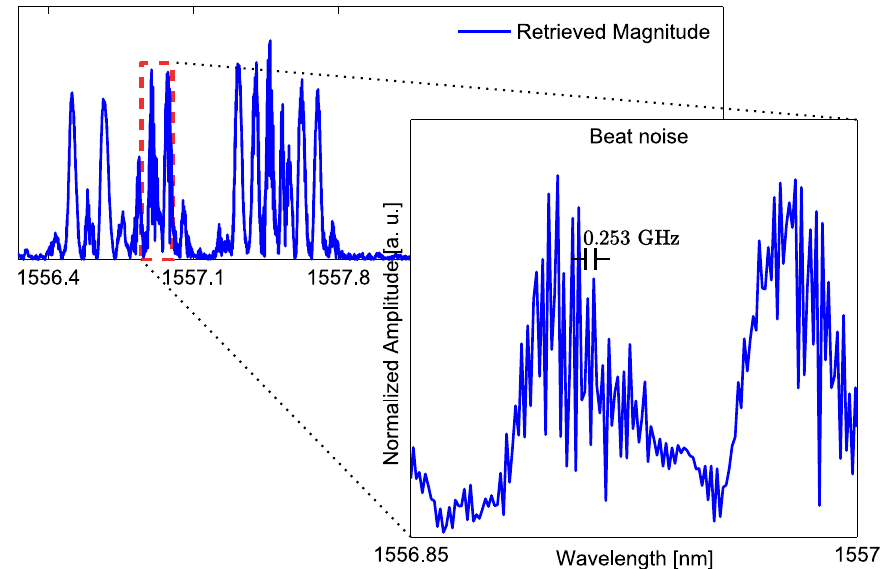
Figure 5. Zoomed-in region from a VNA readout. Ripple frequency due to overlapping between two sub-bands is measured to have a frequency of about 0.253 GHz, which is consistent with the placement distance between sensors of approximately 40 cm. (The x-axis represents the scanned wavelength and y-axis represents the normalized